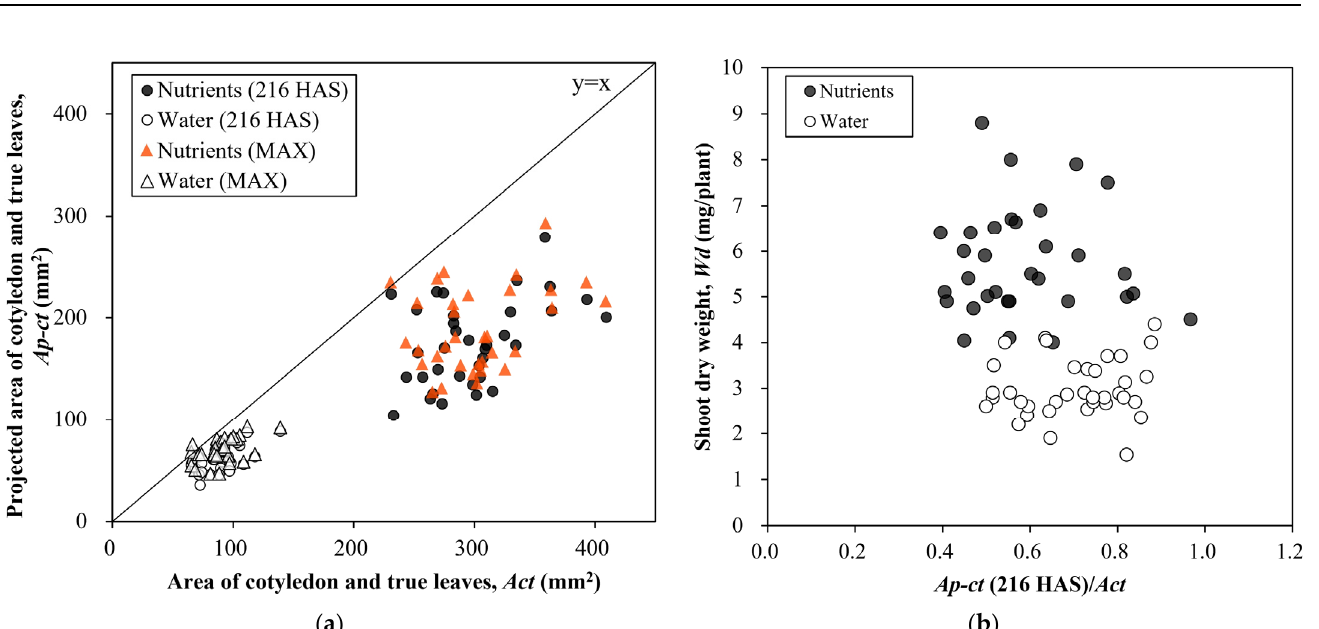
Figure 5. ( a ) The projected area of cotyledon and true leaves of the individual plants ( Ap-ct ) and area of cotyledon and true leaves of individual plants 216 h after sowing (HAS) ( Act ), with nutrients and water. The Ap-ct includes its value at 216 HAS and the maximum value over 216 h. ( b ) The ratio between Ap-ct and Act ( Ap-ct / Act ) together with shoot (cotyledon, true leaves, hypocotyl, and petiole) dry weight ( Wd ) all at 216 HAS with nutrients and water.